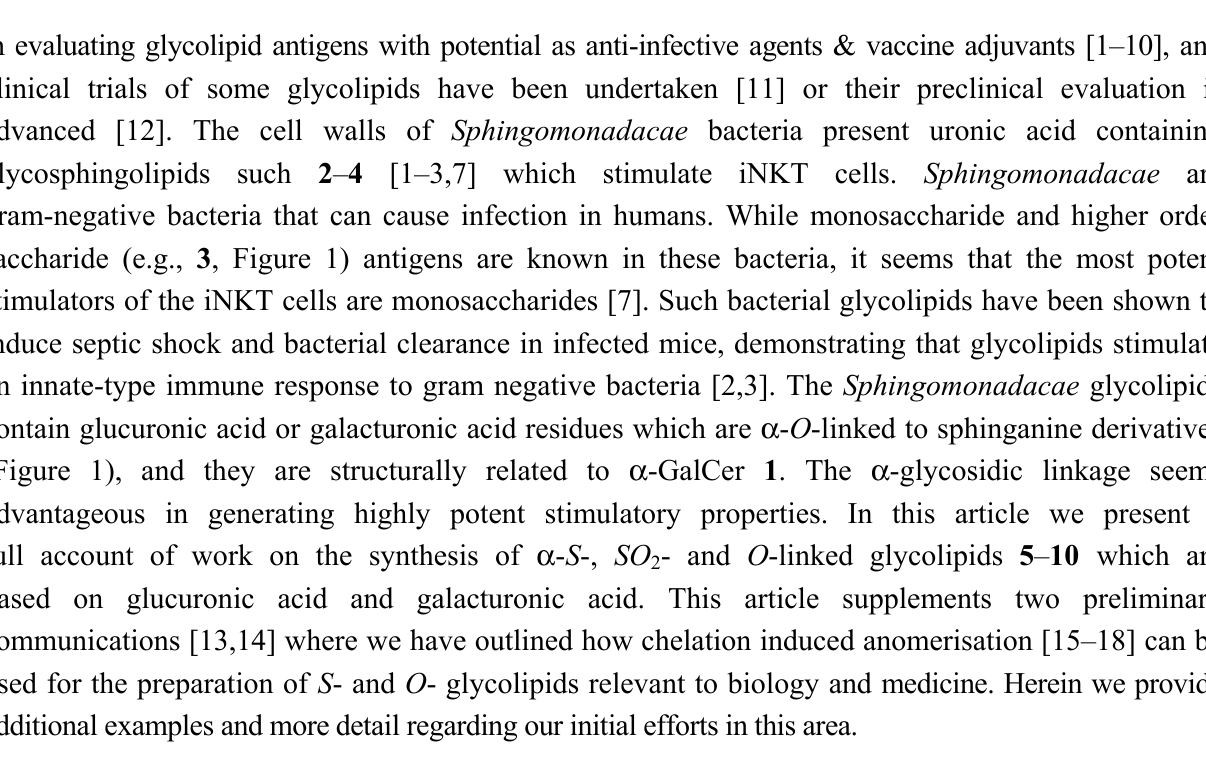
Figure 1. Structures of glycosphingolipids 1 – 10